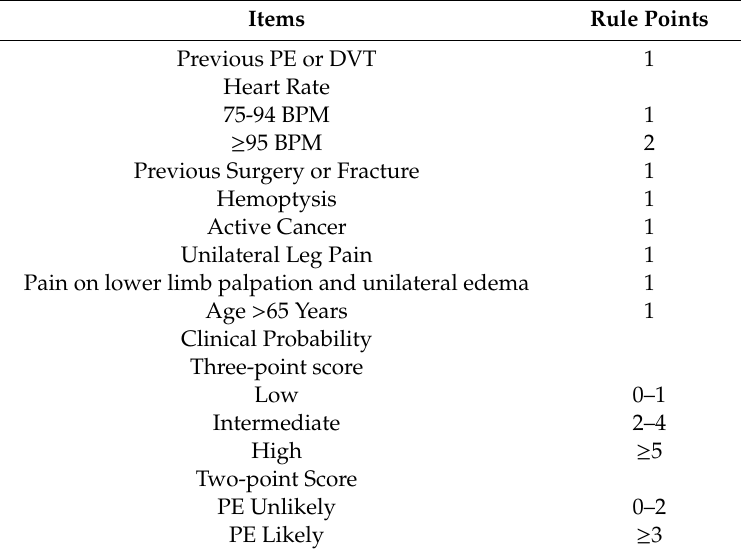
Table 1. Revised Geneva score to assess pre-test probability of PE [31]. Items Rule